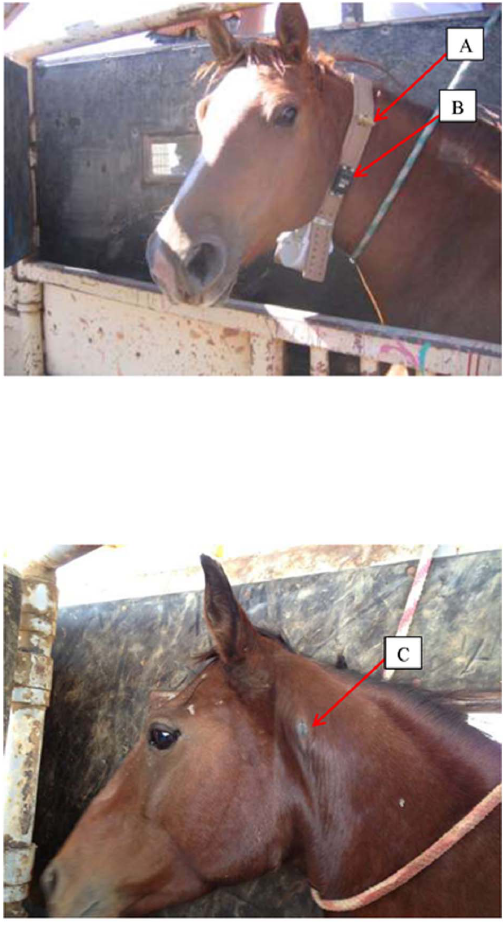
Figure 4. An adult free-roaming horse during collar deploy- ment and a second horse after collar detachment. First photo: area to right of rope is where a micro-chip was implanted, A: breakaway device constructed of rubber tubing, B: breakaway device using pre- programmed timed-release; Second photo: C: only a small callus and typical slight hair wear is in evidence along the upper portion of the neck and mane where the collar was situated for 3 years.